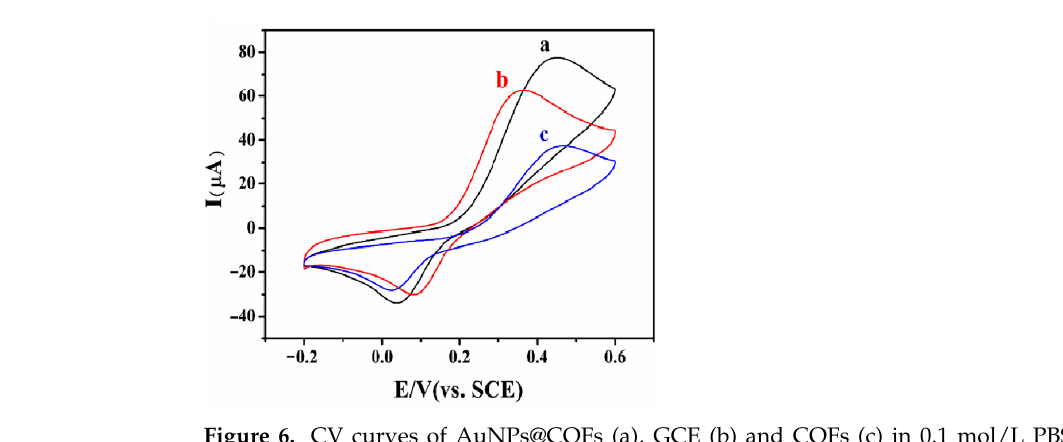
8 of 14 Figure 5. ( A ) CV curves of AuNPs@COFs (a), GCE (b) and COFs (c) in in 0.5 mmol/L [Fe(CN) 6 ] 3 − /4 − and 0.1 mol/L KCl electrolyte solution; ( B ) EIS of AuNPs@COFs nanocomposites (a), GCE (b) and COFs (c) in 0.5 mmol/L [Fe(CN) 6 ] 3 − /4 − and 0.1 mol/L KCl electrolyte solution. The response of different modified electrodes to ractopamine was studied by cyclic voltammetry (CV). As shown in Figure 6, the peak current response of COFs/GCE(c) to ractopamine was lower than that of bare GCE(b), which may be due to the poor conduc-